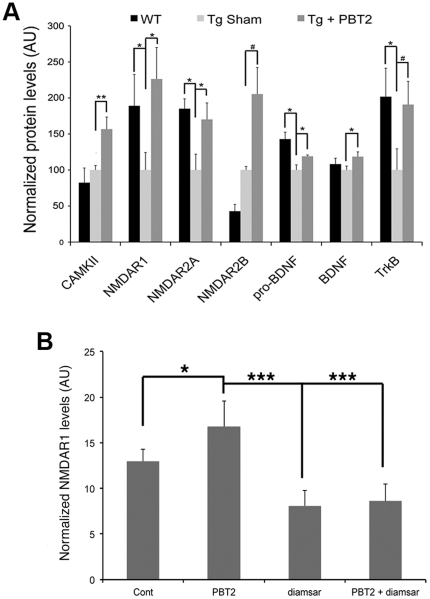
Biochemical profiles in Tg2576 and wildtype littermate mice and in cell culture.(A) Tg2576 mice have significant deficits in a number of proteins, as compared to age-matched wildtype controls, and PBT2-treatment significantly increases the expression of a number of these proteins to the levels seen in the control mice. Values have been normalized to the mean of Tg Sham group = 100. (B) The effect of PBT2 on NMDAR1 protein levels in SH-SY5Y cells is abolished in the presence of the high affinity chelator, diamsar (n = 6/treatment). *p<0.05, **p<0.01, #p = 0.06.